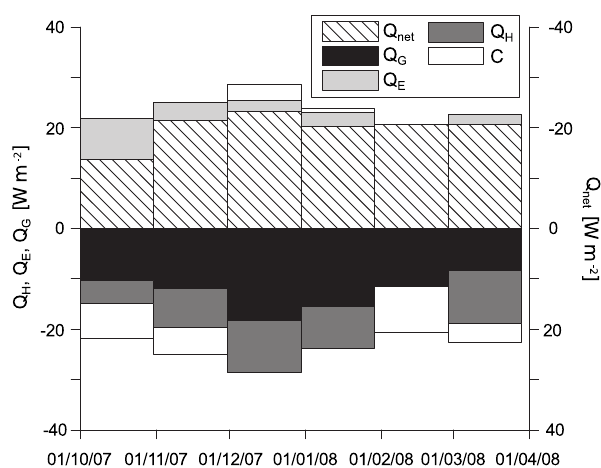
Fig. 5. Monthly averages of energy balance components for the winter